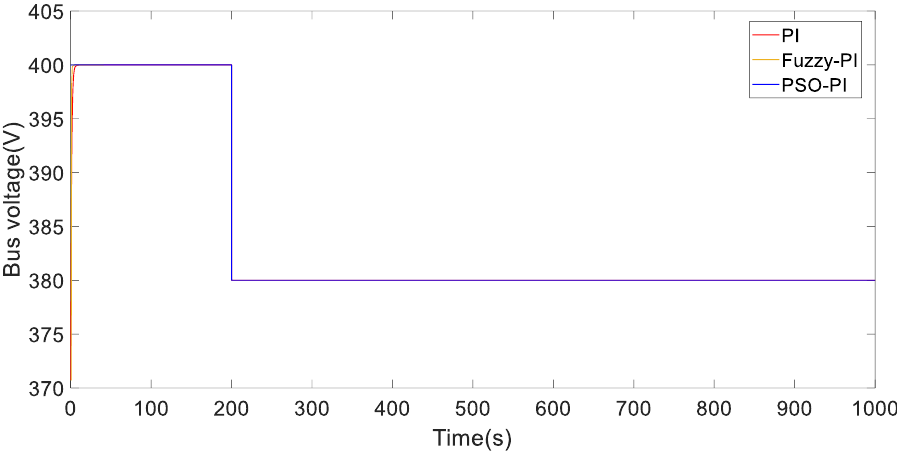
Figure 34. DC bus voltage when one generator fails without AA-CAES .